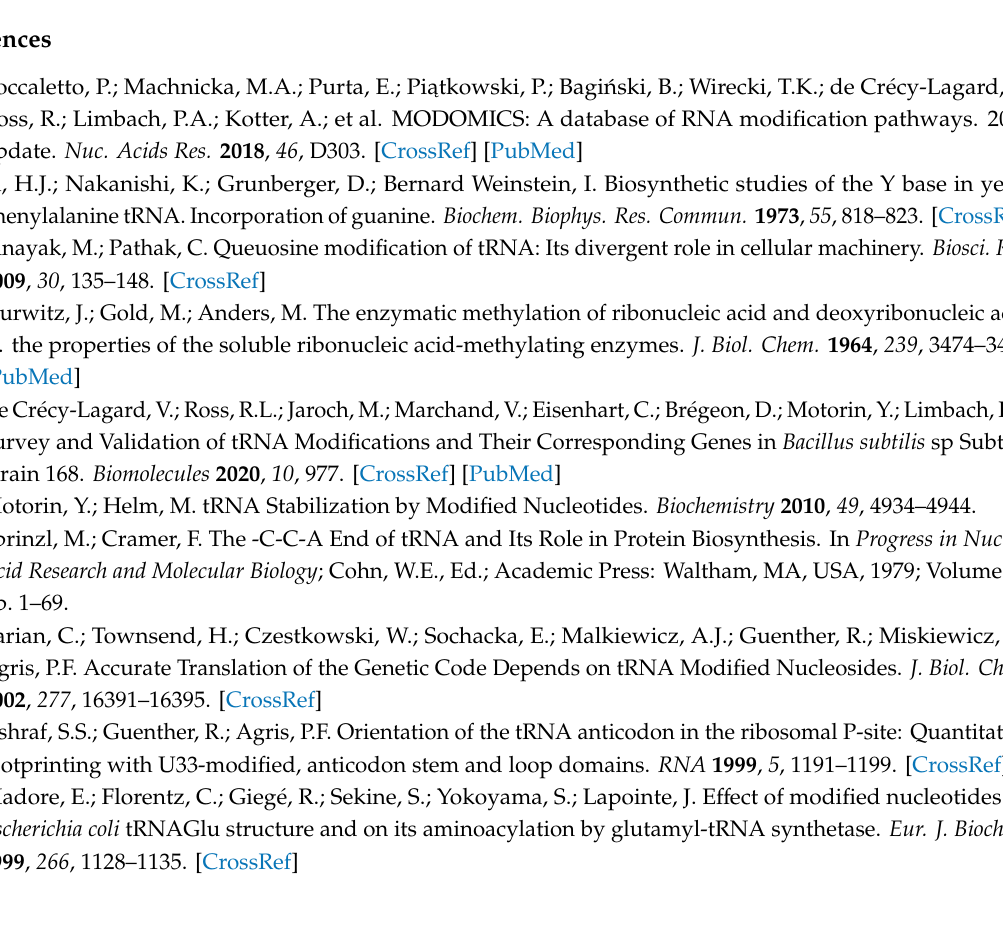
Table S1. tRNA modifications with corresponding positions and varying types of stressors that a ff ect each respective modification